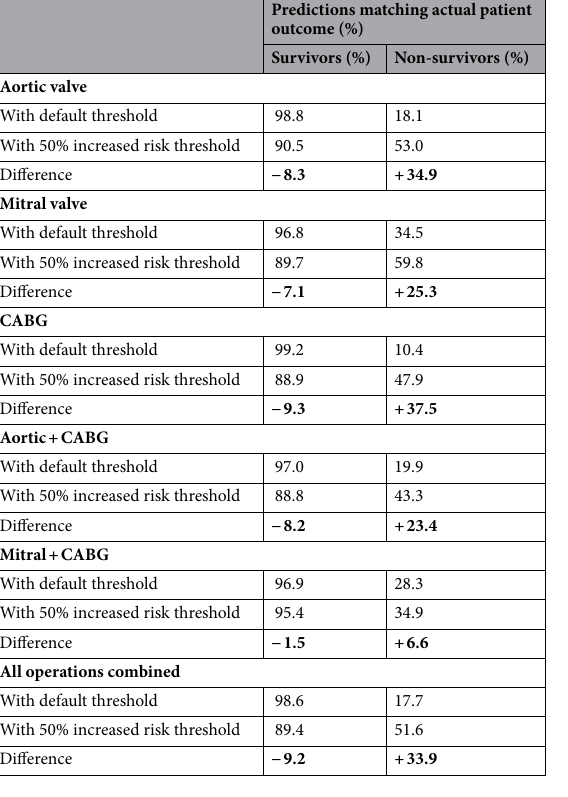
Table 2. Percentage of correctly classified cases in survivors and non-survivors per operation type for SL1 predictions using the default and 50% increase in risk